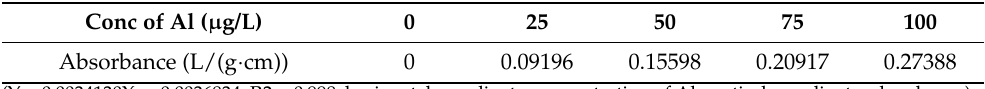
Table 4. The elemental Al standard curve values. Conc of Al ( µ